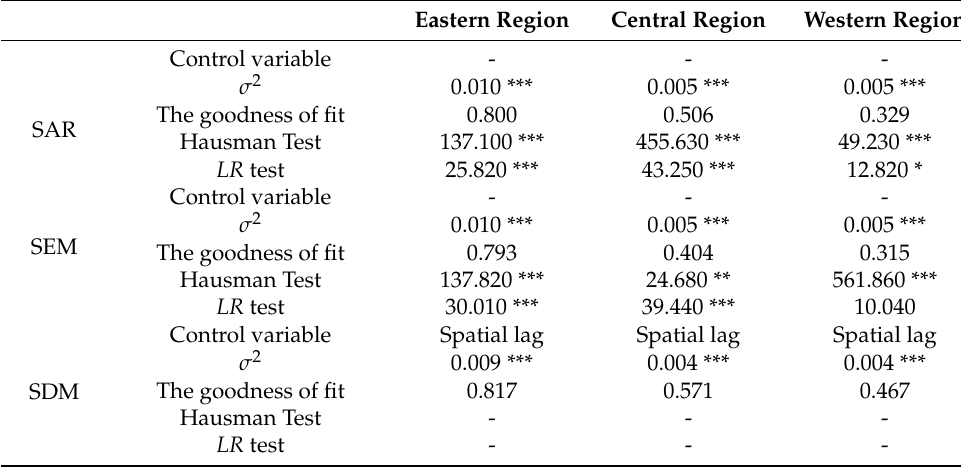
Table 8. Partial regression results of eastern, central and western models.